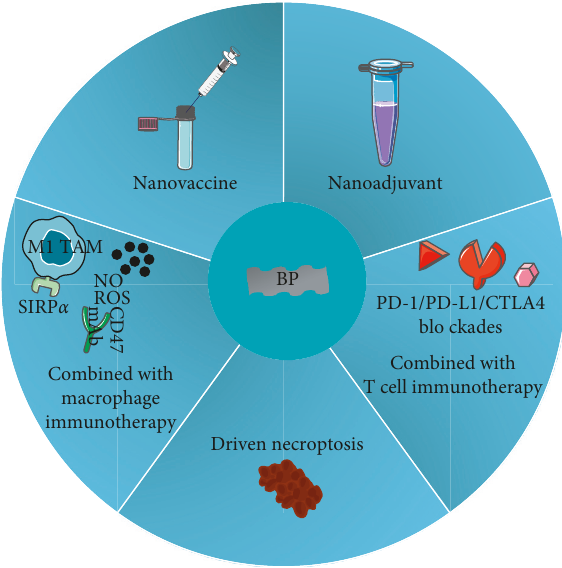
Figure 1: The potential application of BP in